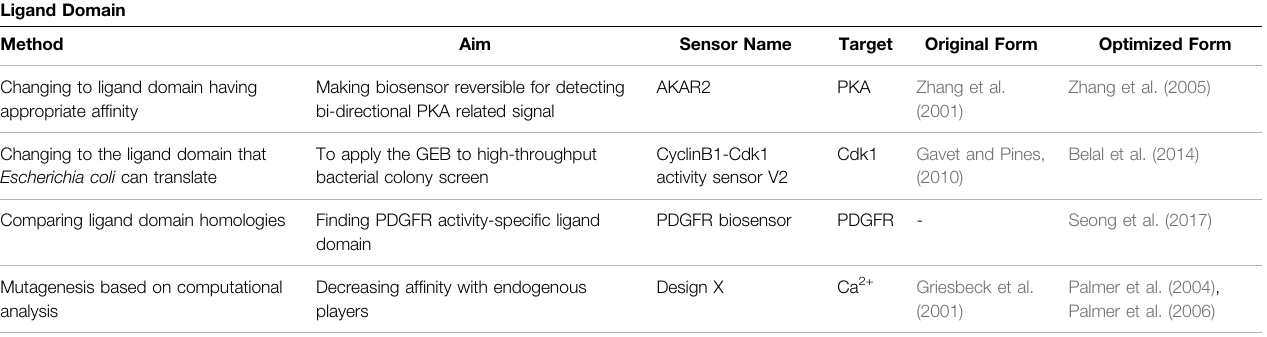
TABLE 2 | Summary of ligand domain optimization